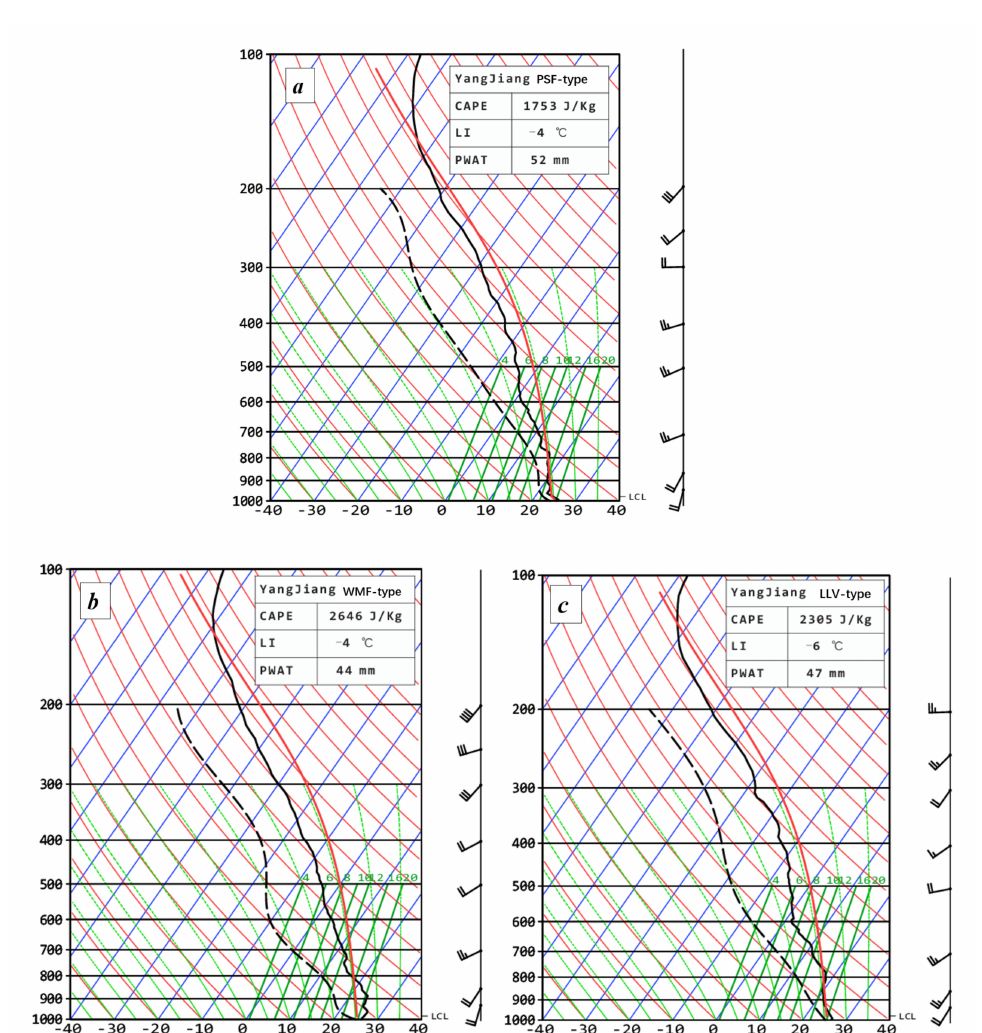
Figure 10. Composite Skew-T/Log P diagrams for the ( a ) PSF-, ( b ) WMF-, and ( c ) LLV-type WSHR events, which are taken at the Yangjiang station at 0800 BST that are far ahead of the approaching MCSs in both the location and timing. A full barb is 4 m s − 1